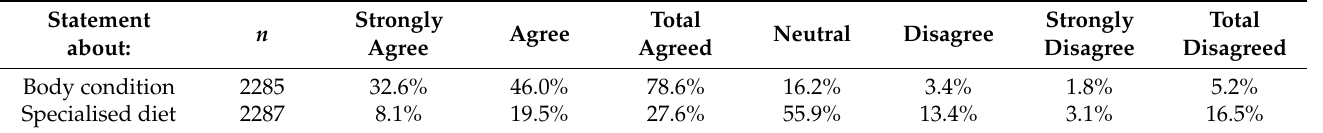
Table 3. Percentage of 2019 NZ Pet Survey respondents selecting each level of agreement for